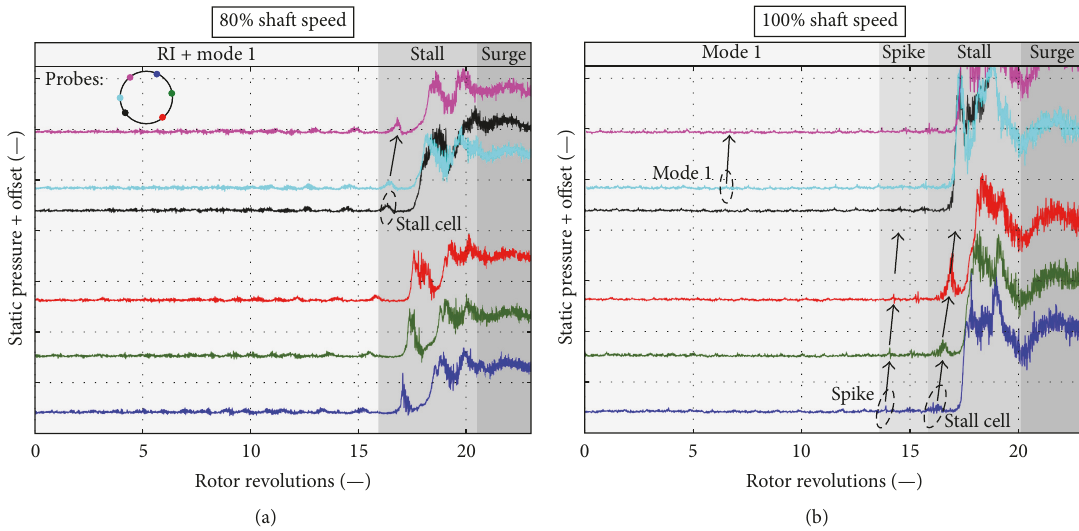
Figure 3: Static pressure signals (low-pass filtered below BPF) of six probes around the circumference upstream of the rotor 1 LE during stall inception at 80% (a) and 100% (b) shaft speed with an identical scale.